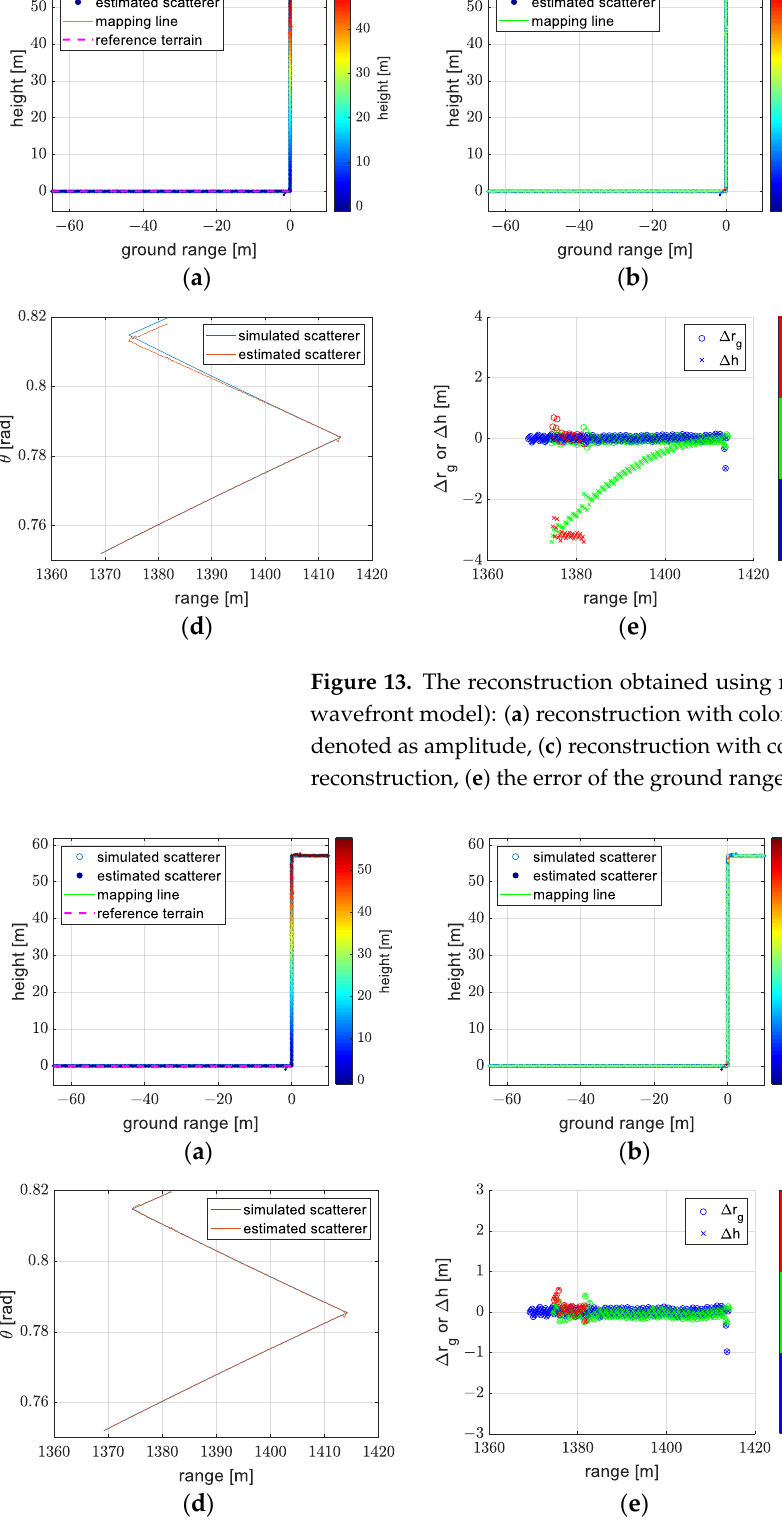
( f ) Figure 15. The reconstruction obtained using model 6 (the approximate form of the spherical wave- front model): ( a ) reconstruction with colors denoted as height, ( b ) reconstruction with colors